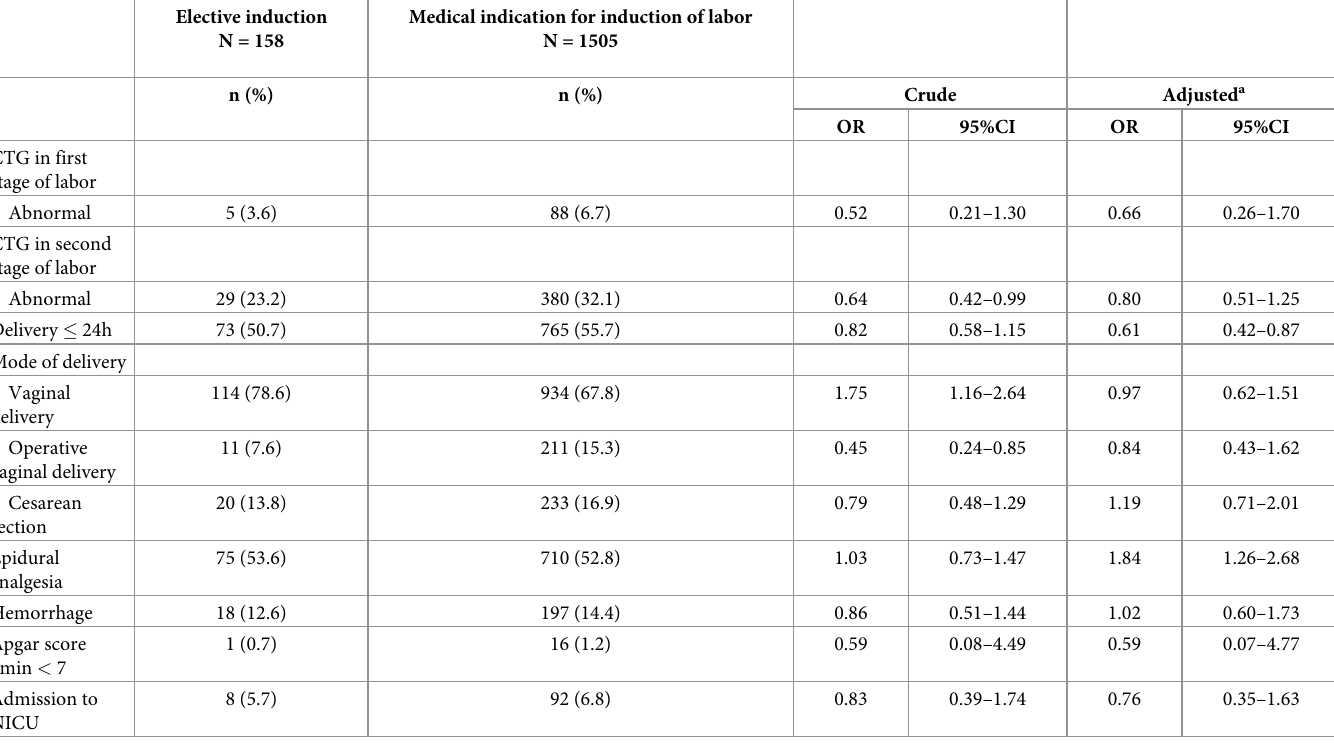
Table 3. Logistic regression analyses of maternal and fetal outcomes for elective induction of labor vs. medical induction of